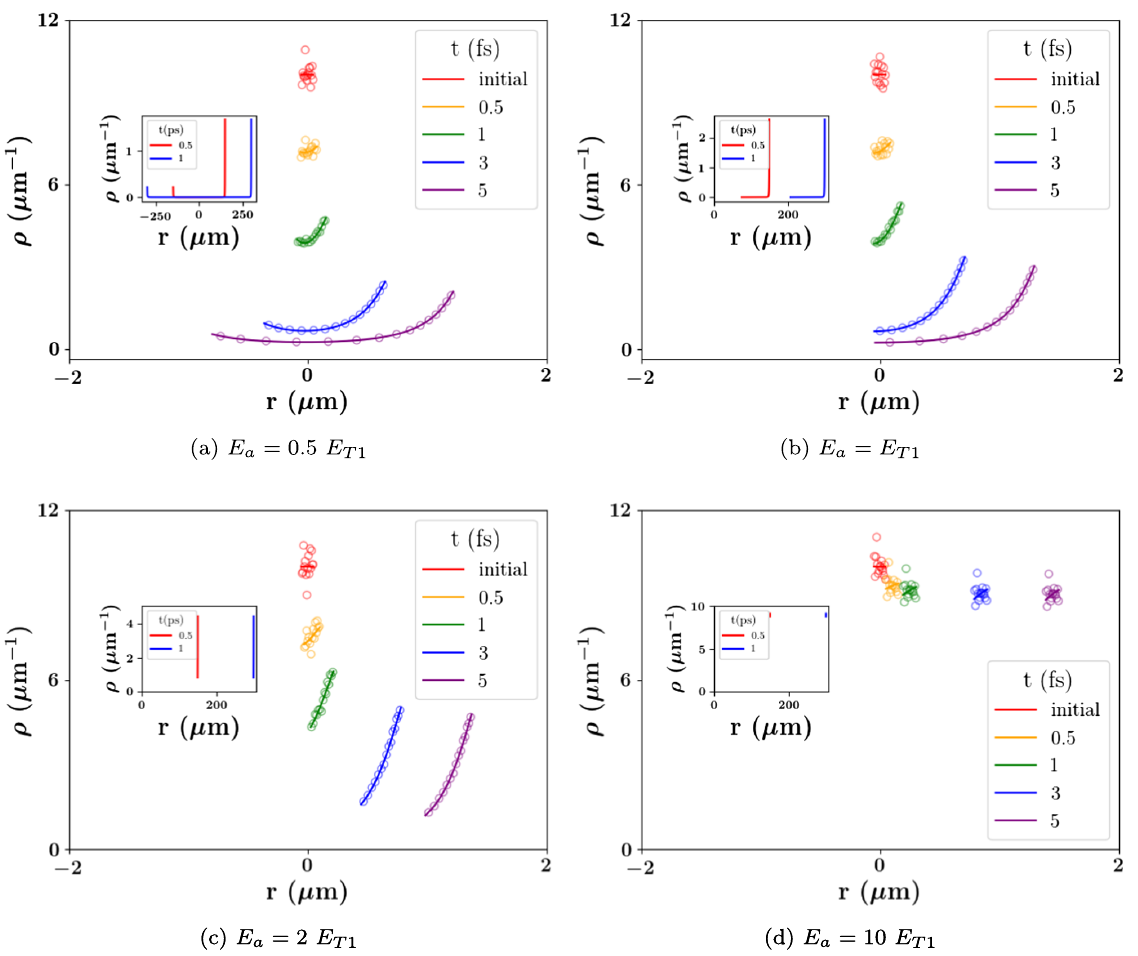
FIG. 11. Theoretical predictions (solid line) and M -shell simulations (hollow dots) of the planar symmetric density at 4 different times with different applied extraction fields: (a) E Q is the total surface-charge density. The simulation had L ¼ 0 . 1 μ m and Q tot ; 1 The extremely high density was chosen as this density not require significant expansion of the bunch before the onset of relativistic effect. Simulations were similar to those described in Fig. 3, and again the inset graphs show the theoretic density at 2 much later times (0.5 and 1 ps). While the distributions at later times appear deltalike, they do have at least the same width as seen at earlier time — however, this width is much smaller than the scale resulting in the deltalike behavior at later times. Notice that in the main plot the scales are consistent among graphs. Also notice that the extraction fields have little effect on where the front of the bunches are after 1 ps but have dramatic effect on the bunch distribution — this is partially an artifact of the high density of the initial distribution that results in the front of the distribution relatively quickly becoming relativistic with or without an extraction field. In addition to the shape of the asymptotic density, the extraction field determines to what extent the initial variance about the mean- field theory prediction is lost (an effect explained in the